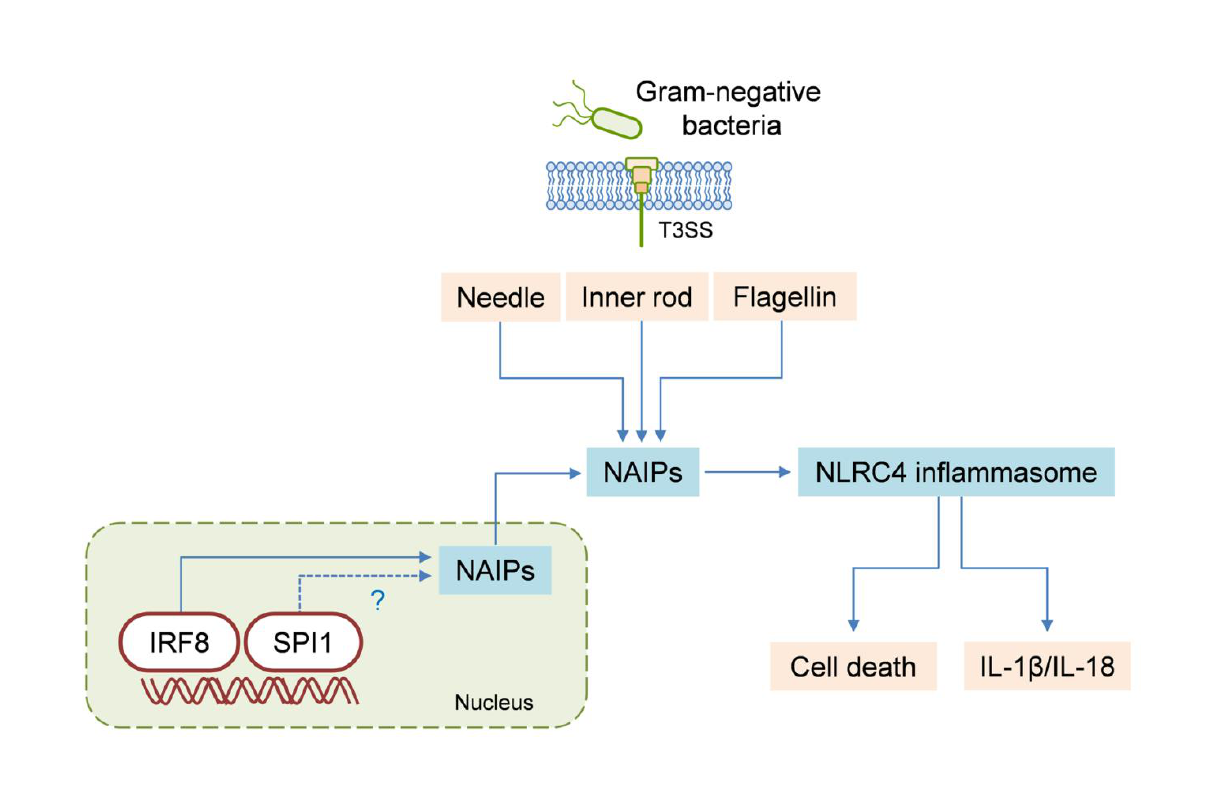
FIGURE 1: IRF8 regulates NLRC4 inflammasome activation . NAIPs are the cytosolic receptors that sense bacterial proteins, specifically the type III secretion system (T3SS) needle, the T3SS inner rod, and flagellin. IRF8 is required for the transcription of genes encoding NAIPs, and SPI1 may also have a role in that process. The detection of bacterial proteins via NAIPs activates the NLRC4 inflammasome, leading to cell death and IL-1β/IL-18